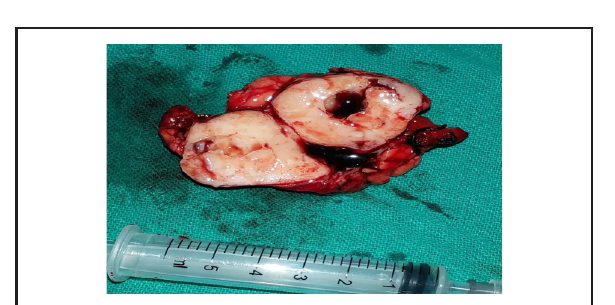
Figure 3 .A well-encapsulated, heterogeneous hard mass with cystic area on center of mass on cut section.